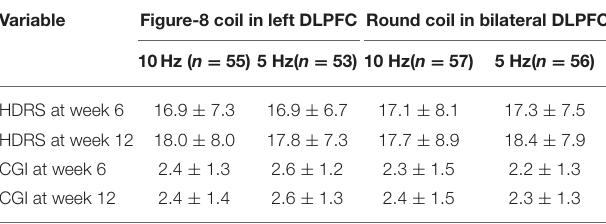
TABLE 2 | The decrease of HDRS score and CGI score at week 6 and week 12. Variable Figure-8 coil in left DLPFC Round coil in bilateral